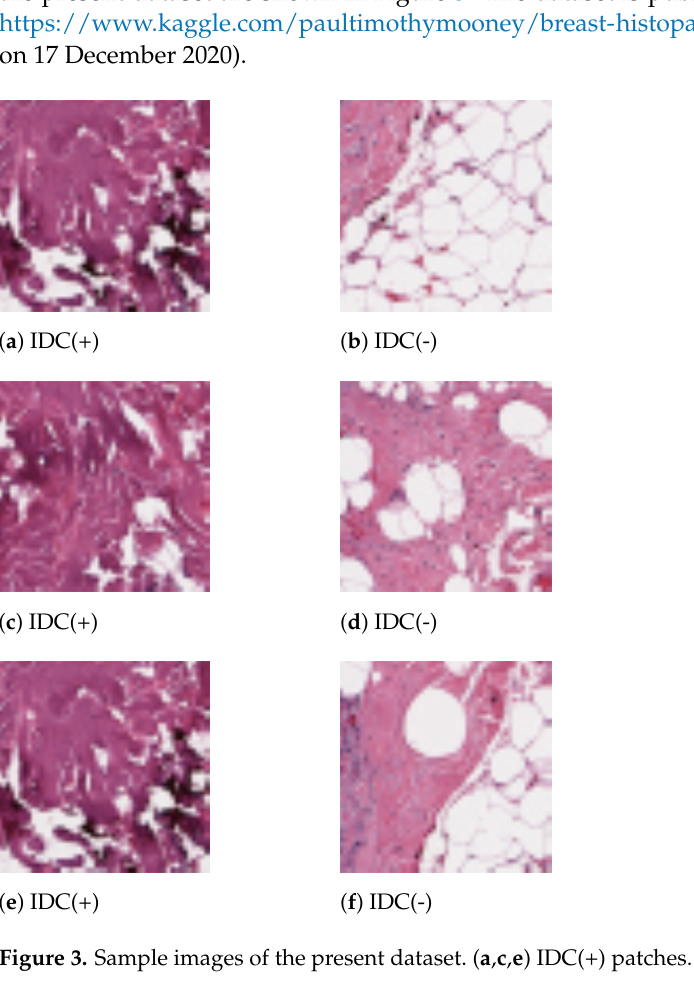
Figure 3. Sample images of the present dataset. ( a , c , e ) IDC(+) patches. ( b , d , f ) IDC(-)